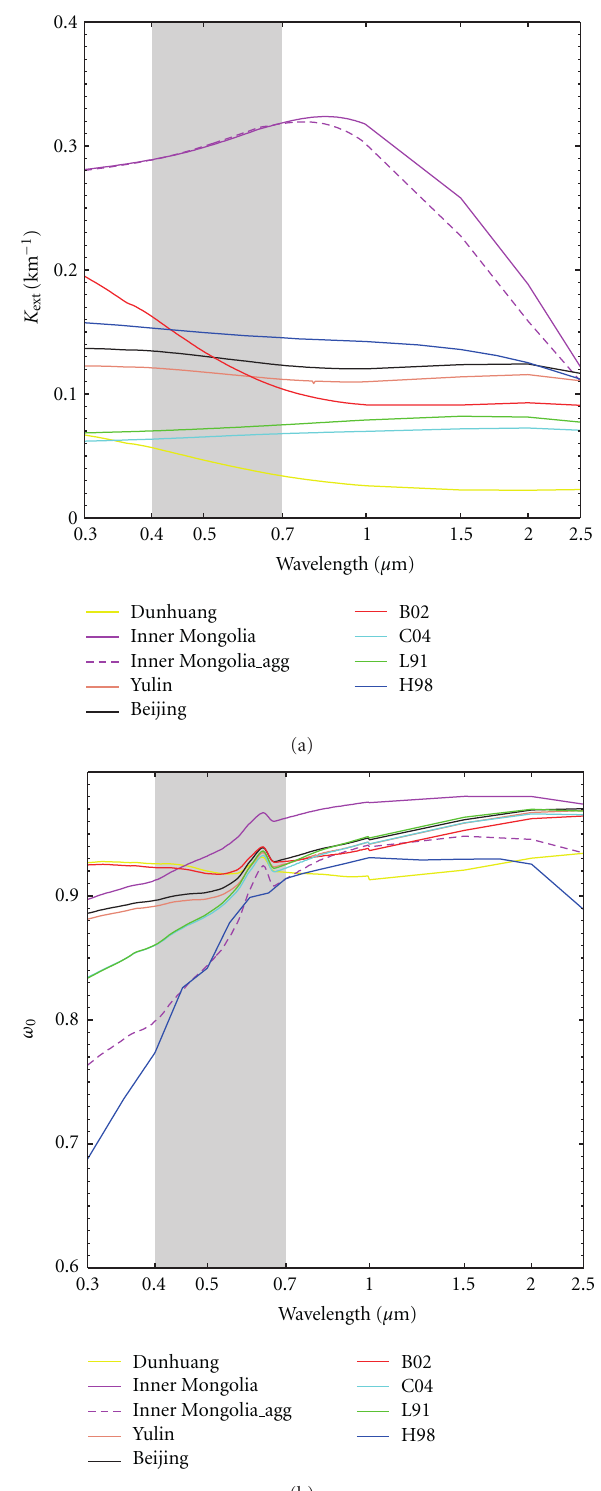
Figure 4: (a) Extinction coe ffi cient K ext for dust loading M = 250 μ g m − 3 , and (b) single scattering albedo ( ω 0 ) computed for Asian dust and OPAC bulk dust (H98) cases. Shaded areas highlight the PAR spectral